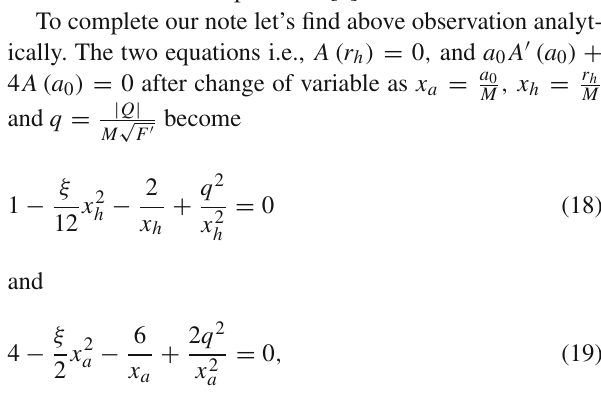
Fig. 1 A plot of V (cid:4)(cid:4) ( a 0 ) > 0 versus x = a 0 is shown as the shaded area. Also a 0 r h (brown long-dashed curve) are plotted (horizontal axis x ) versus M √ y = | Q | satisfying a 0 A (cid:4) ( a 0 ) + 4 A ( a 0 ) = 0 and A ( r h ) = 0 respec- M F (cid:4)